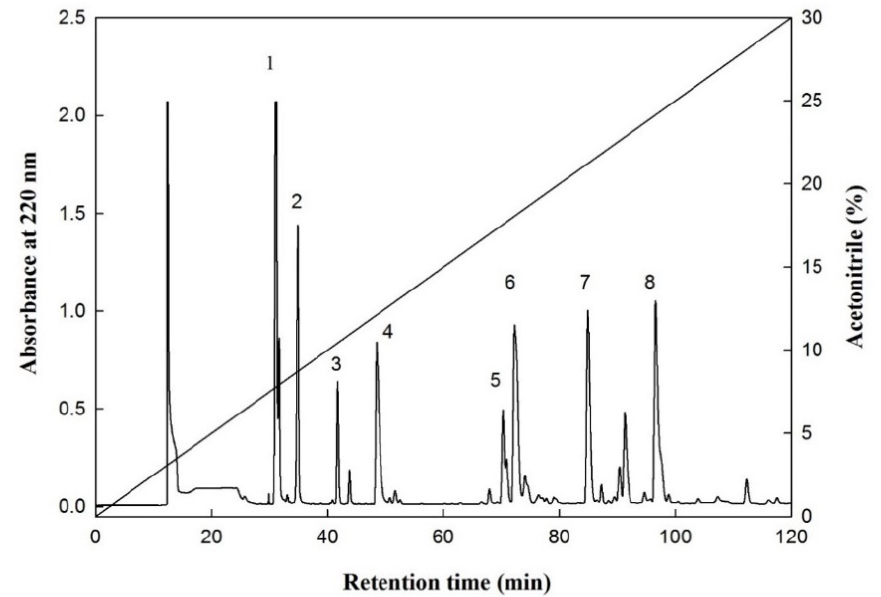
Figure 2. An elution profile of the fraction E from F-HHP + PN-6 + PP by reversed-phase HPLC. Column: Synergi 4u Hydro-RP 80A (250 × 10 mm; particle size, 4 µ m; Phenomenex, Torrance, CA, USA); elution A (deionized water containing 0.1% trifluoroacetic acid (TFA) and B (100% acetonitrile containing 0.1% TFA); mobile phase: linear gradient from 0% to 30% of B within 120 min; and flow rate of 1.0 mL/min at room temperature, and detection at 220 nm. (1–8: numbers of the peaks).